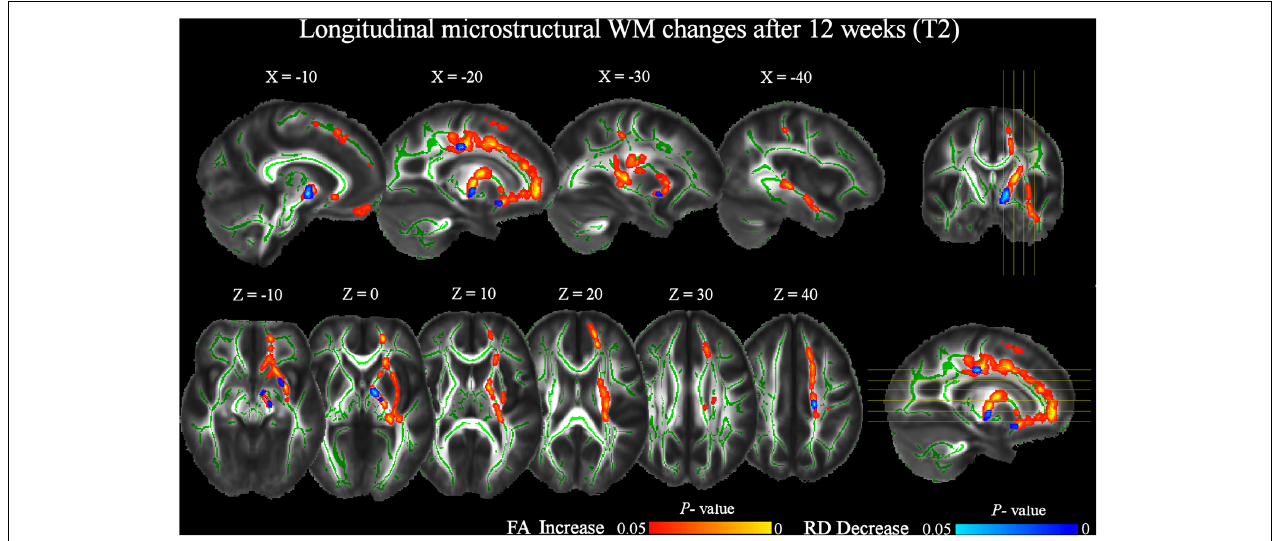
FIGURE 4 | Significant increases in FA and decreases in RD after 12 weeks of daily QMT (T2) respect to T0 baseline (pFWE < 0.05, TFCE corrected). See Figure 3 for additional details. TABLE 4 | Significant increases in FA at T2 respect to T0 (pFWE < 0.05 TFCE-corrected). MNI coordinates